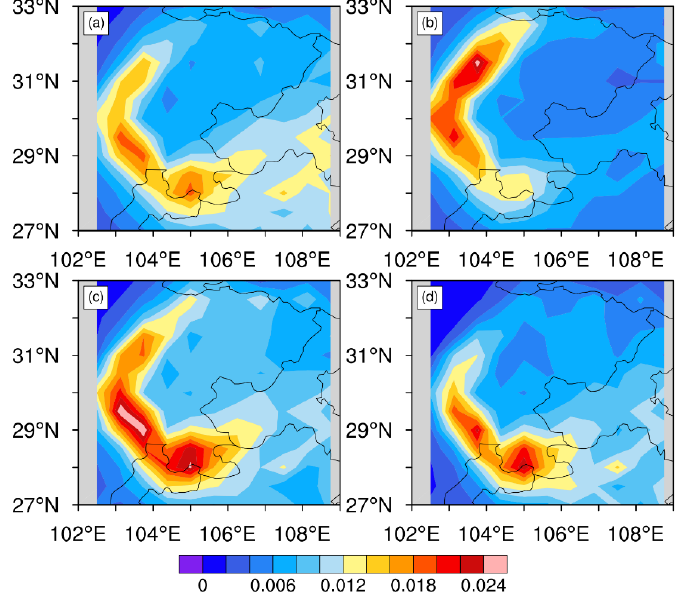
Figure 4. Mean spatial distribution of black carbon wet deposition flux in spring ( a ), summer ( b ), autumn ( c ), and winter ( d ) over the Sichuan Basin during 1981–2020. Unit: μg m −2 s −1 .